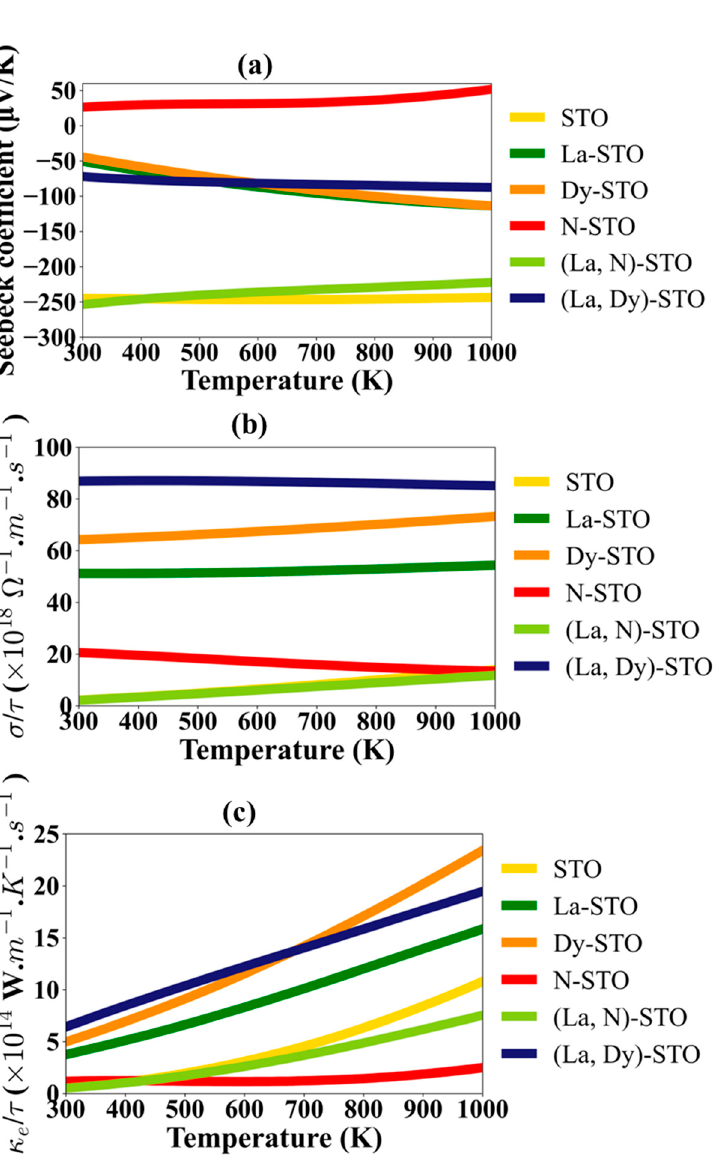
Figure 7. ( a ) Seebeck coefficient, ( b ) ratio of electrical conductivity to relaxation time, and, ( c ) ratio of the electronic thermal conductivity to relaxation time of undoped and doped STO.